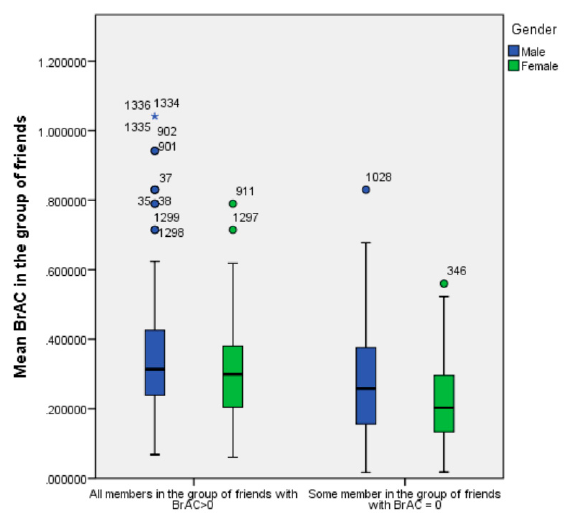
Figure 3. Boxplot of BrAC by proportion of friends with a BrAC > 0 (all members with BrAC > 0 and some members with BrAC = 0) and gender (male, female).